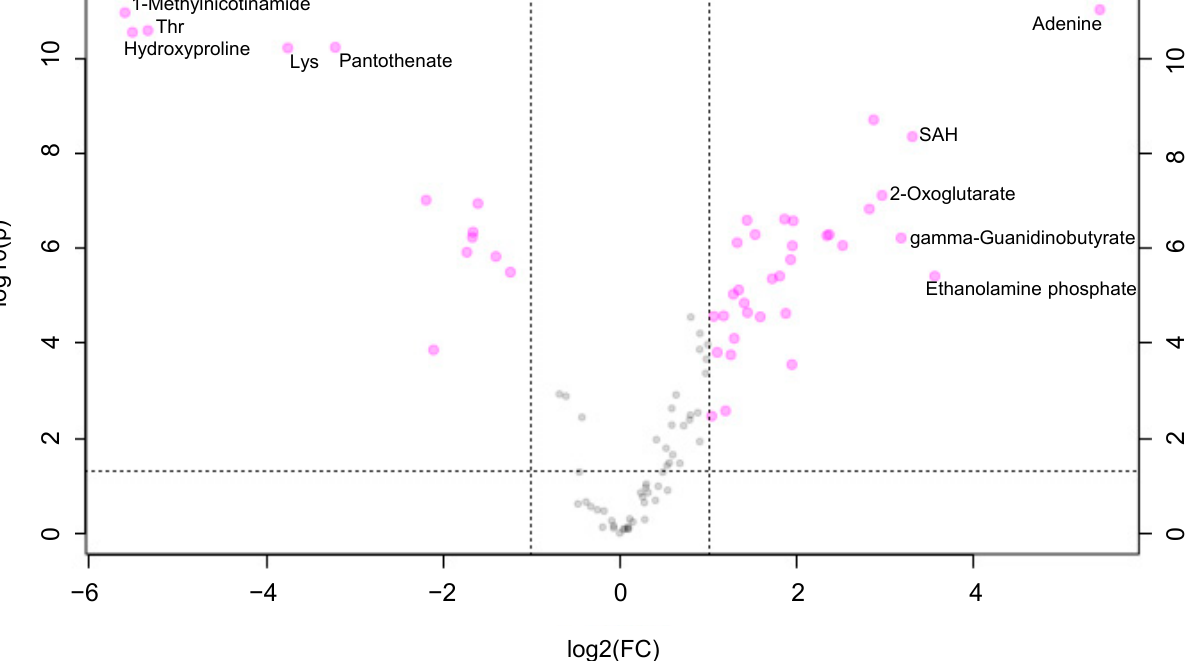
Figure 1. Volcano plots of the metabolomic profile. X-axis indicates the log 2 (fold change (F.C.)) of oral keratinocytes ( n = 7)/fibroblasts cultured ( n = 7) in a 20% oxygen environment. The Y-axis indicates –log 10 (P) using the t -test. Before the calculation of F.C., each metabolite concentration was divided by the average concentration of each sample to eliminate sample-dependent bias. Each plot indicates a metabolite. The metabolites showing a large difference in F.C. (log 2 (F.C.) < − 1 or 1 < log 2 (F.C.)) and small p -value ( p < 0.05) were colored in